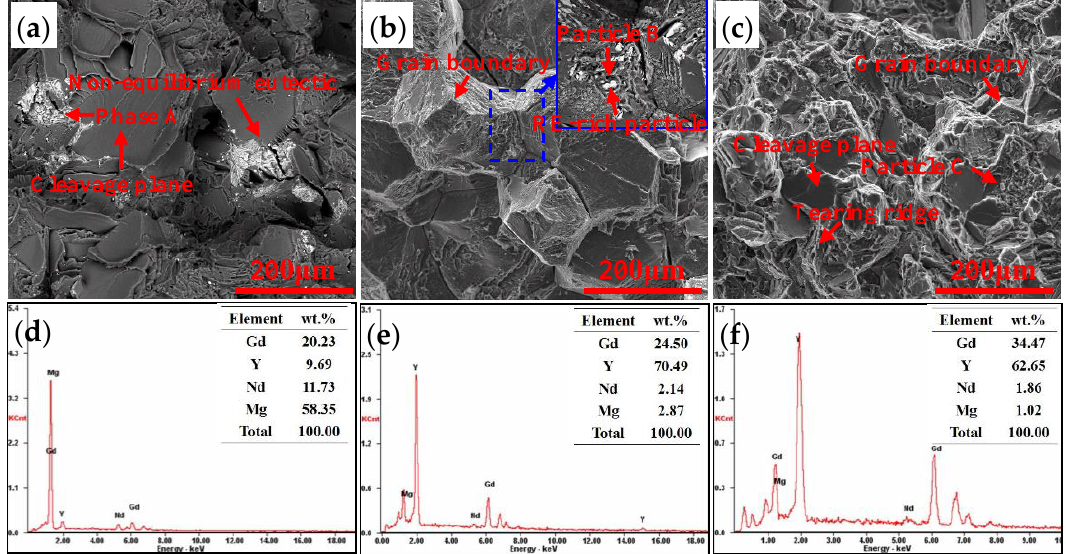
Figure 9. SEM images and EDS results of the fracture surfaces of alloys with different Gd, Y contents: ( a ) SEM image of alloy A ( b ) SEM images of alloy B ( c ) SEM image of alloy C ( d ) EDS results of phase A ( e ) EDS results of particle B ( f ) EDS results of particle C.